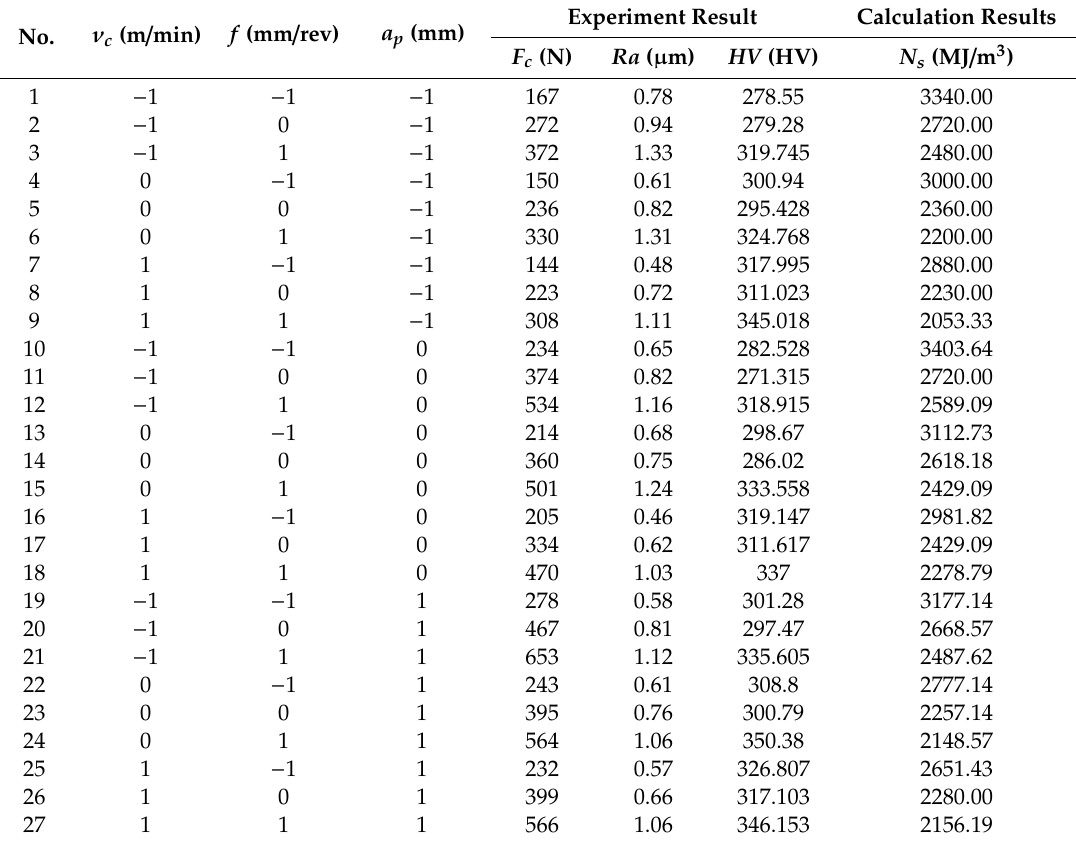
Table 4. Design and results of the